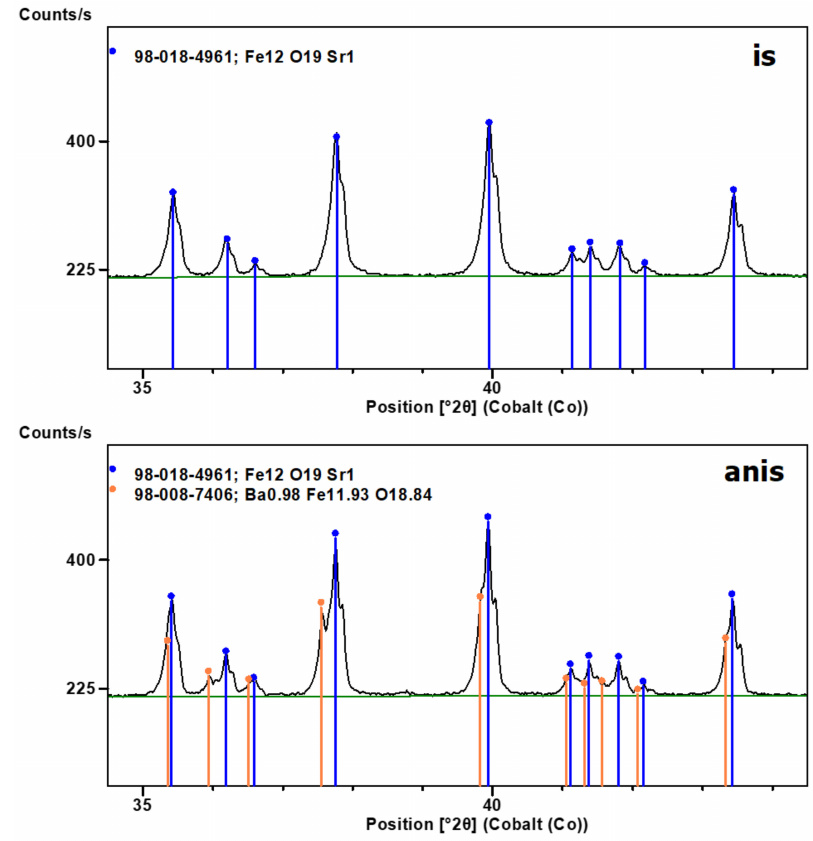
Figure 3. XRD patterns of is-SrFe 12 O 19 and anis-SrFe 12 O 19 .